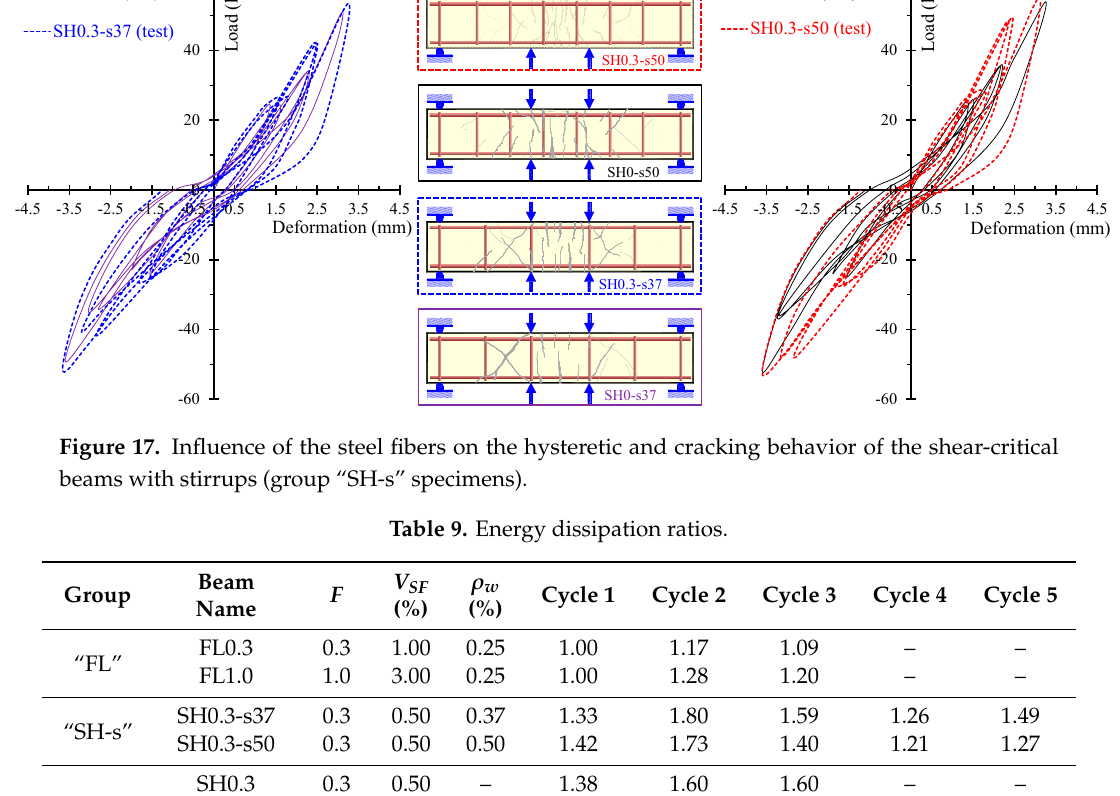
Table 9. Energy dissipation ratios.